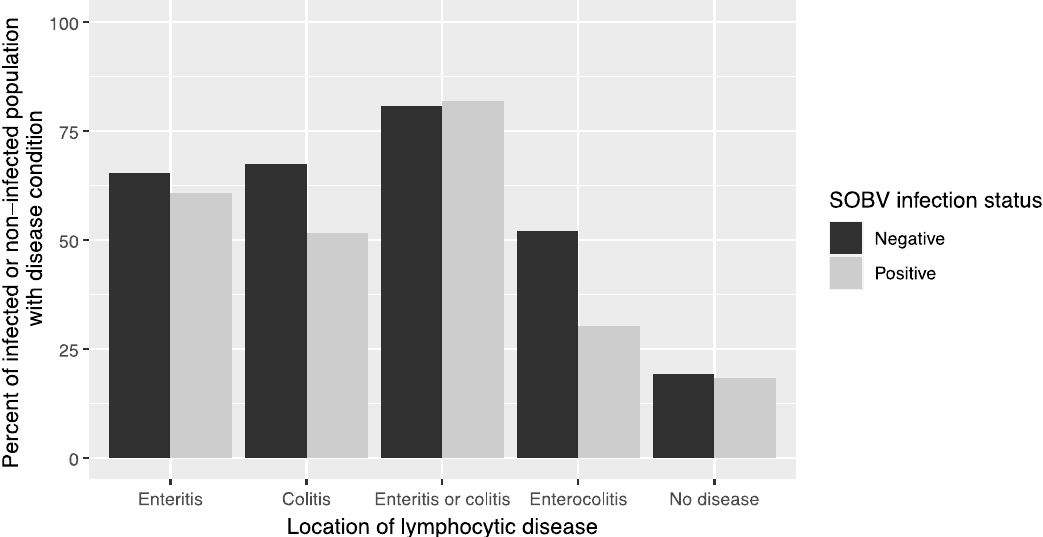
Figure 6. Infection with SOBV is not associated with the likelihood of developing lymphocytic enteritis, colitis, or enterocolitis. Eighty-five common marmosets at the WNPRC, which had been previously screened for SOBV by RT-PCR or deep-sequencing of plasma samples, were examined postmortem for histological evidence of lymphocytic enterocolitis. Pegivirus infection was not found to be associated with an increased likelihood of developing lymphocytic colitis ( p = 0.196), enteritis ( p = 0.779), either enteritis or colitis ( p = 0.820), enterocolitis ( p = 0.0798), or lack of lymphocytic disease ( p = 0.904), using univariate logistic regression.